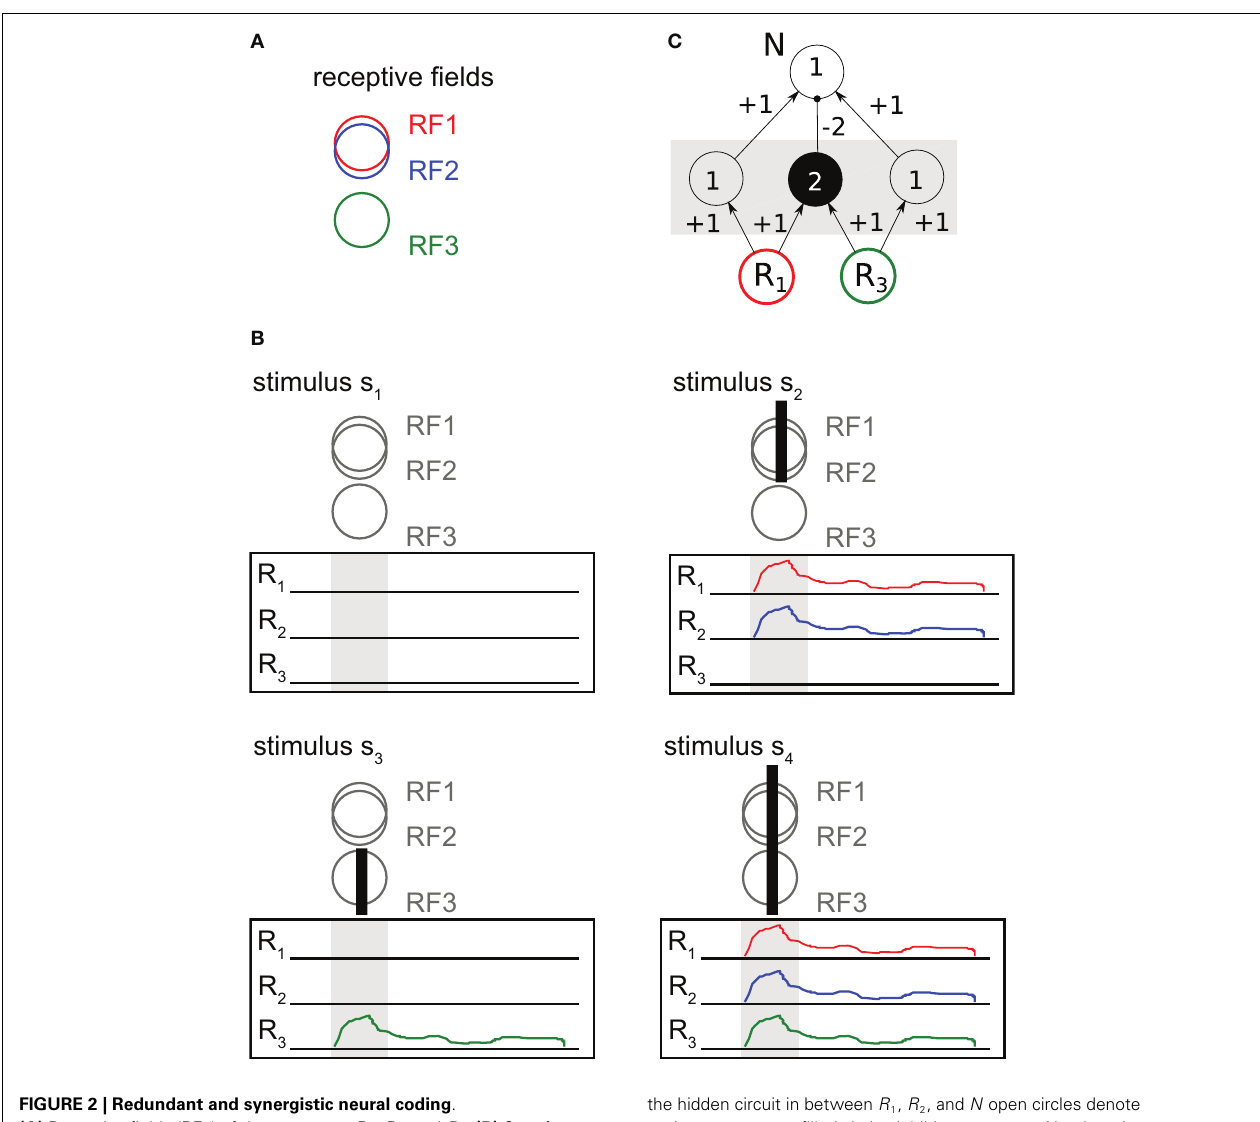
FIGURE 2 | Redundant and synergistic neural coding . (A) Receptive fields (RFs) of three neurons R 1 , R 2 , and R 3 . (B) Set of four stimuli. (C) Circuit for synergistic coding. Responses of neurons R 1 , R 3 determine the response of neuron N via an XOR-function. In